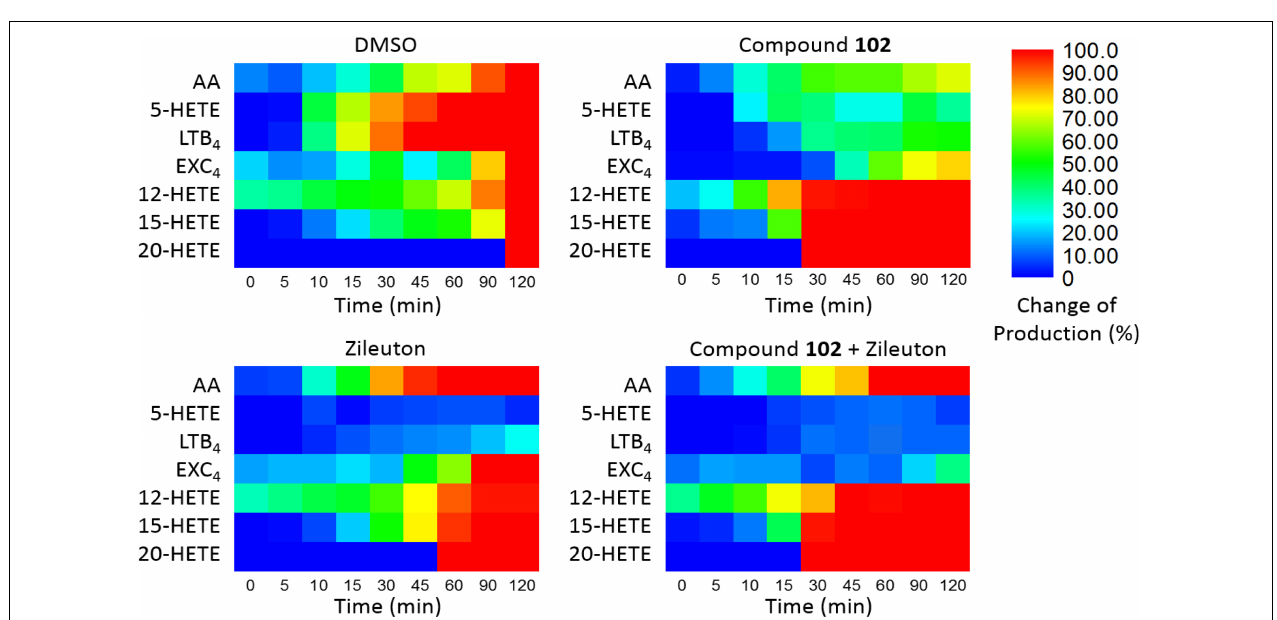
FIGURE 4 | Dynamic eicosanoid production profiles in response to stimulation for 120 min. Changes in eicosanoid production of samples pre-incubated with the vehicle (DMSO), GPX4 activator 102 (125 µ M), the 5-LOX inhibitor Zileuton (1 µ M), and a combination of 125 µ M compound 102 and 1 µ M Zileuton. Change in production was defined as the normalized concentration of eicosanoid relative to that in the control set (vehicle, 120 min) multiplied by 100%. Absolute amounts of eicosanoids formed and standard error of means are given in Supplementary Figures S4, S5 .